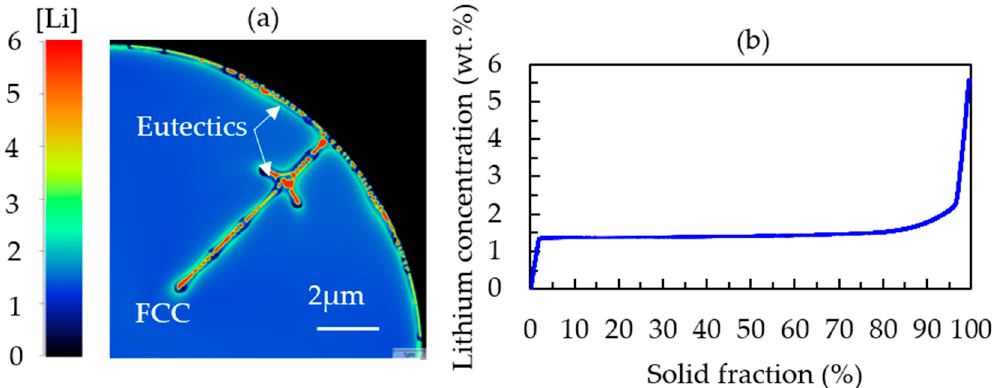
Figure 8. ( a ) Simulated microstructure of a completely solidified Al ‐ 2.63Cu ‐ 1.56Li particle showing the lithium distribution. ( b ) Sorted local lithium concentration values in Al ‐ 2.63Cu ‐ 1.56Li.